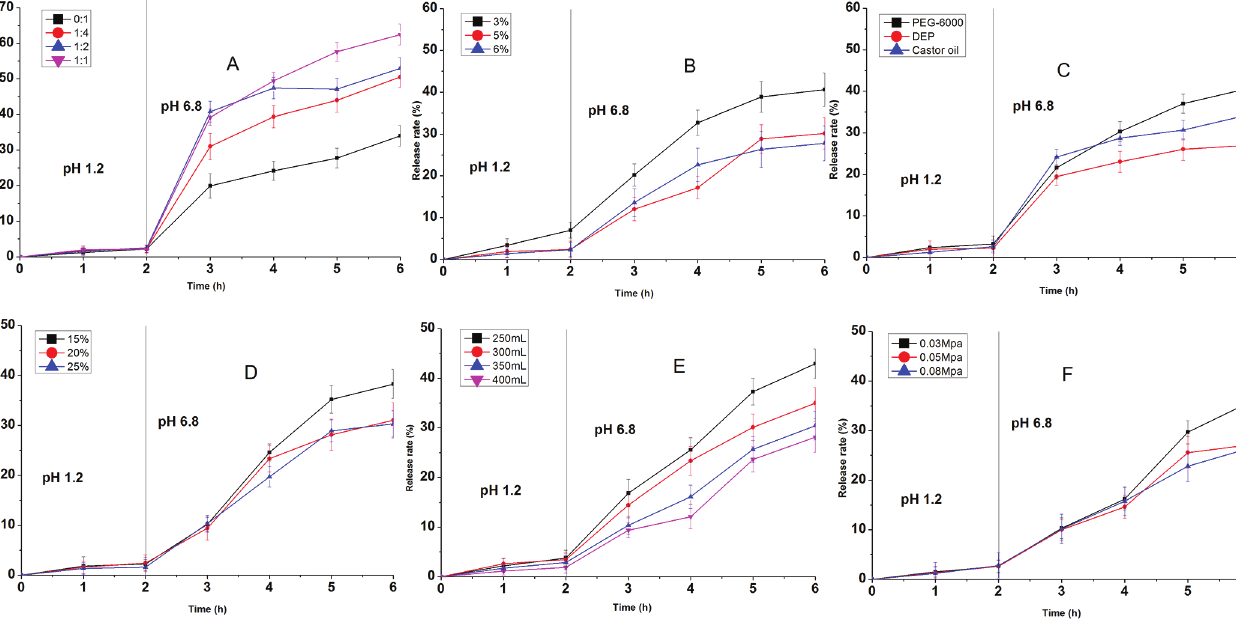
mean L values. The values of L are shown in Table